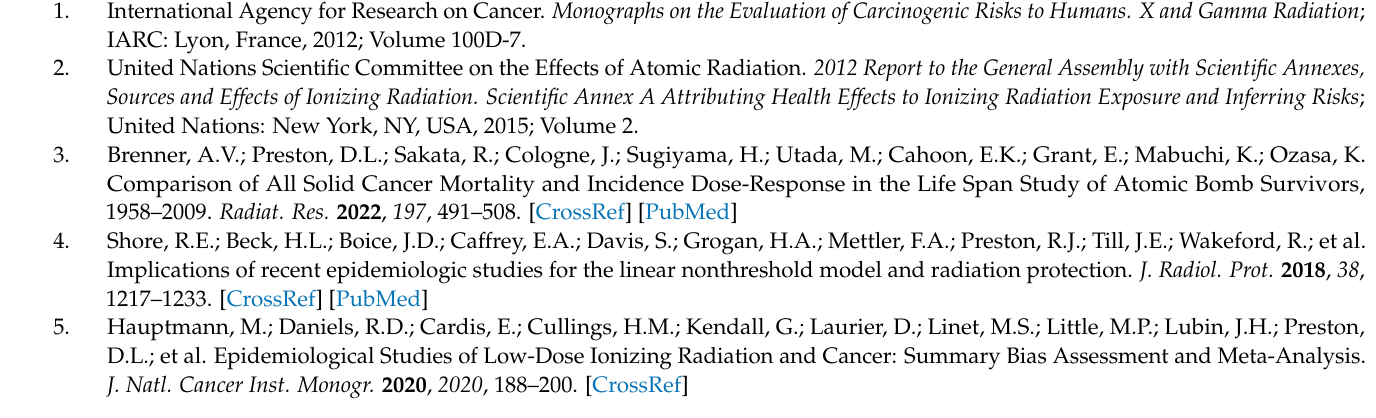
Table S3: Parameter estimates of the excess relative rate (ERR) models for leukaemia (excluding chronic lymphocytic leukaemia) and 2-year lagged cumulative red bone marrow dose in males only, SELTINE cohort, period